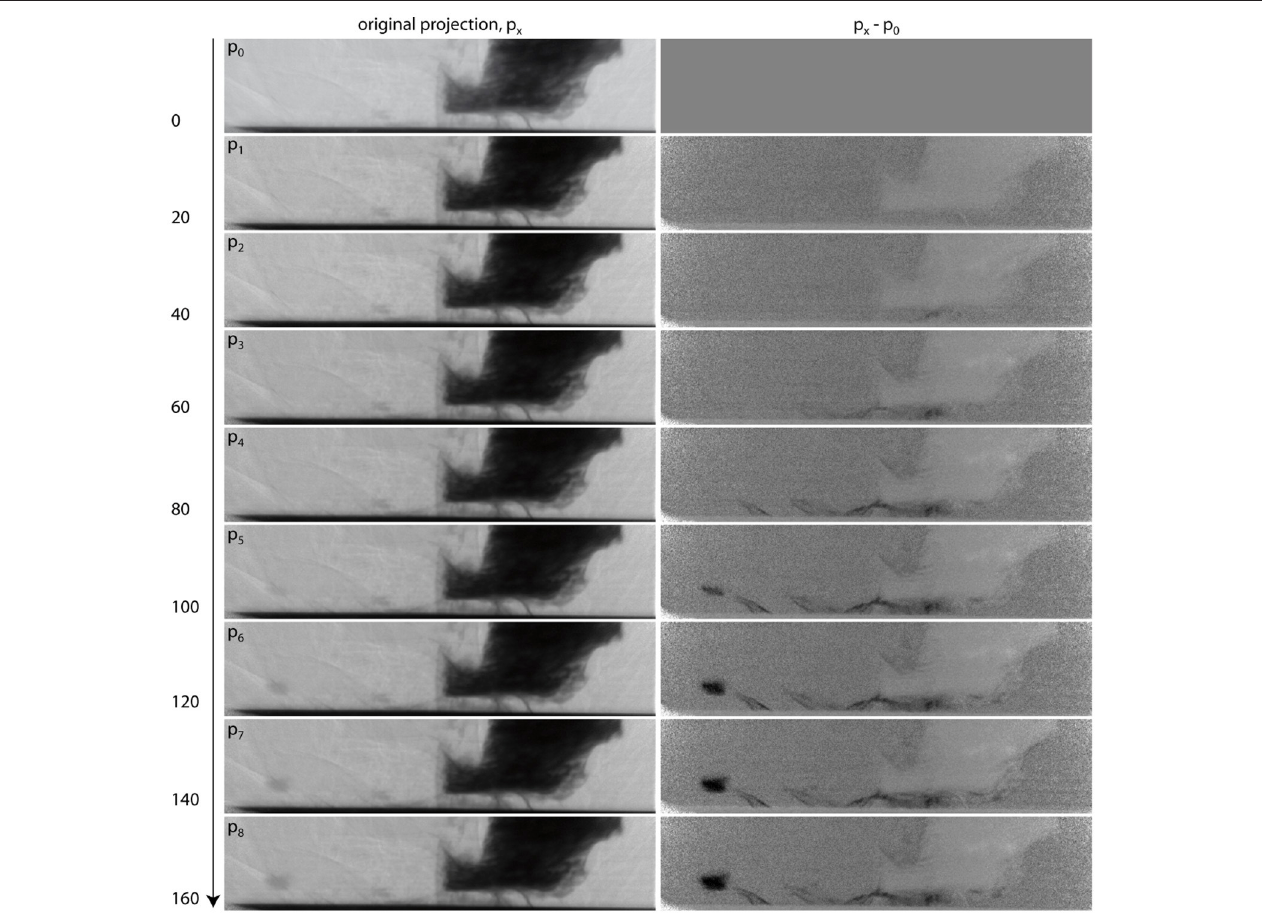
FIGURE 5 | Radiographic projections highlighting Au melt movement during the final heating stage of the experiment. Vertical axis shows total time ins. Left : original projects, Right : projection minus initial projection to highlight changes in the sample volume. Black regions represent increases in attenuation due to accumulation of Au melt, most noticeable in the meandering horizontal melt channel and melt “pocket” toward the bottom the sample volume. There is a corresponding decrease in attenuation in the central melt area due to outward migration of Au melt. After 160s (to final image) no further significant changes were noted in the sample for a further